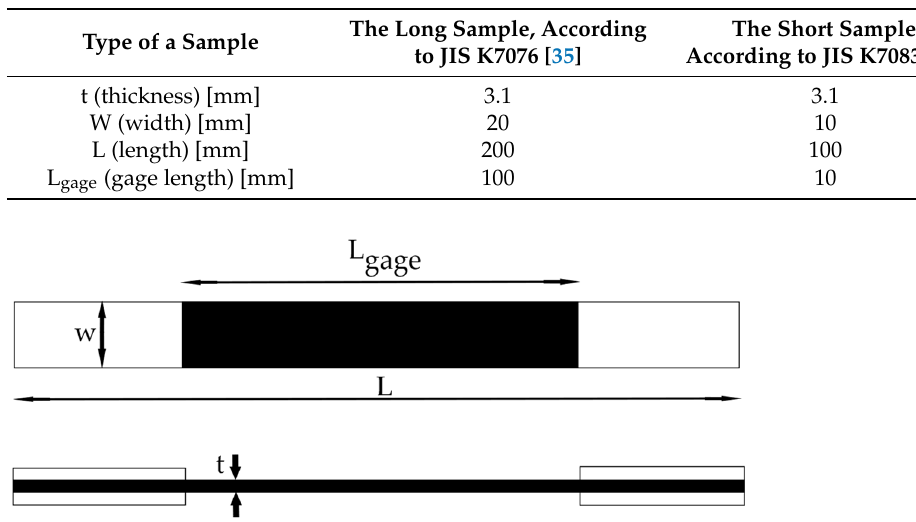
Table 1. The T700S/2592 sample dimensions [34].